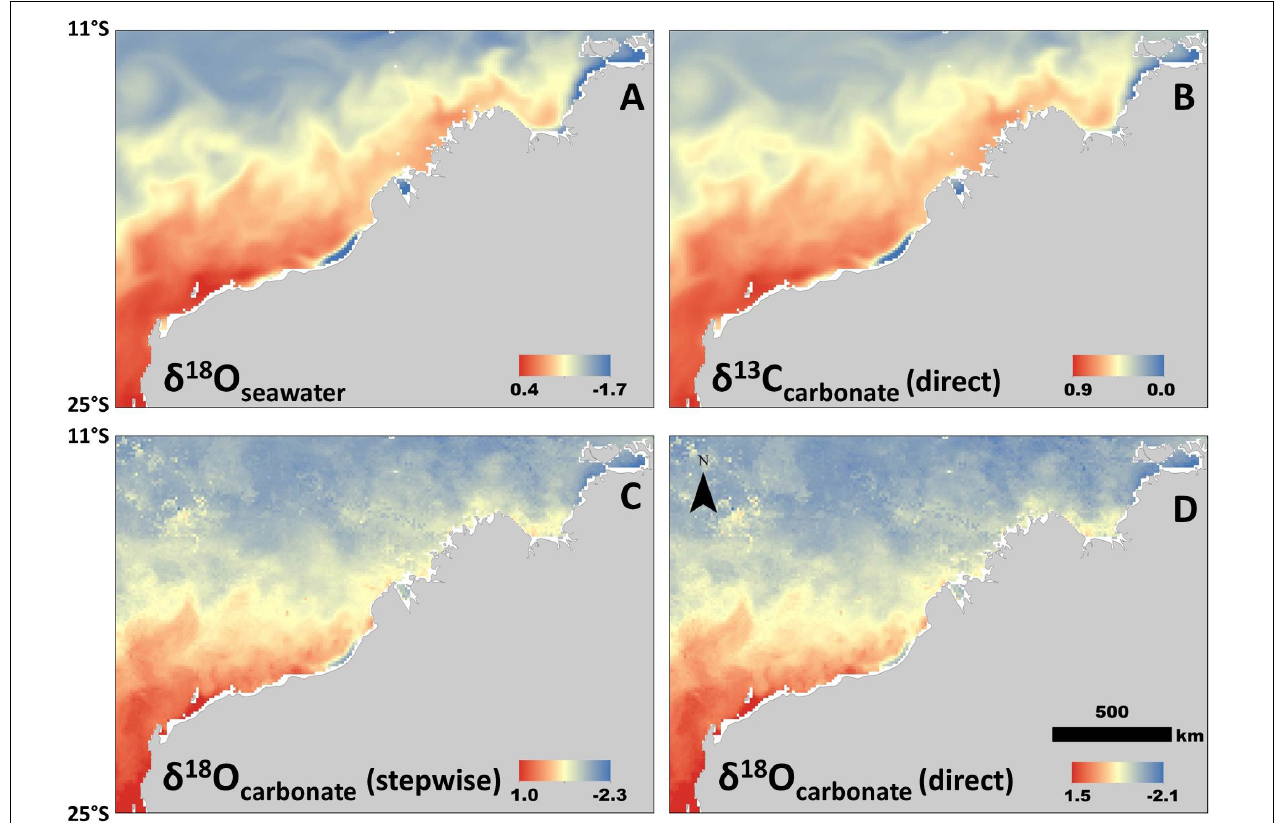
FIGURE 3 | Isoscapes generated from newly derived relationships between isotopes, salinity, and temperature. All are examples of spatial variation during the same period (in this case mean values for 11–20 August, 2016, selected for example only). (A) Isoscape of δ 18 O sw values. (B) Isoscape of δ 13 C values generated from the model that does not include a temperature parameter (Model 3; Table 1 ). (C) Carbonate δ 18 O (stepwise method) isoscape derived from δ 18 O sw -salinity relationship and then generated using the BBPE. (D) Isoscape of carbonate δ 18 O values generated directly from linear regression (Model 1; Table 1 ) without BBPE or δ 18 O sw values. All isotope values in permille ( (cid:104)